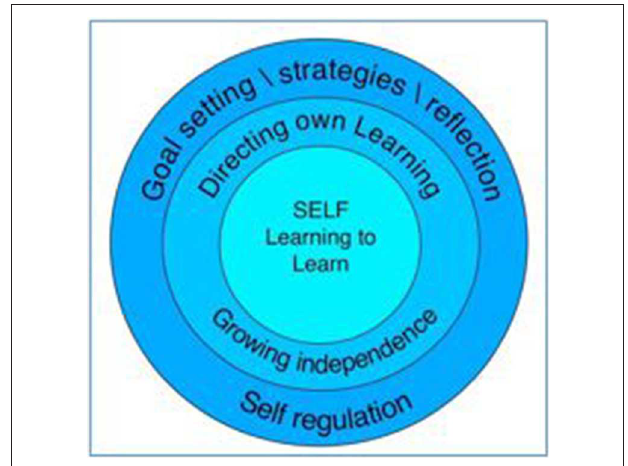
FIGURE 1 | A representation of Boekaerts’ model of self-regulation.